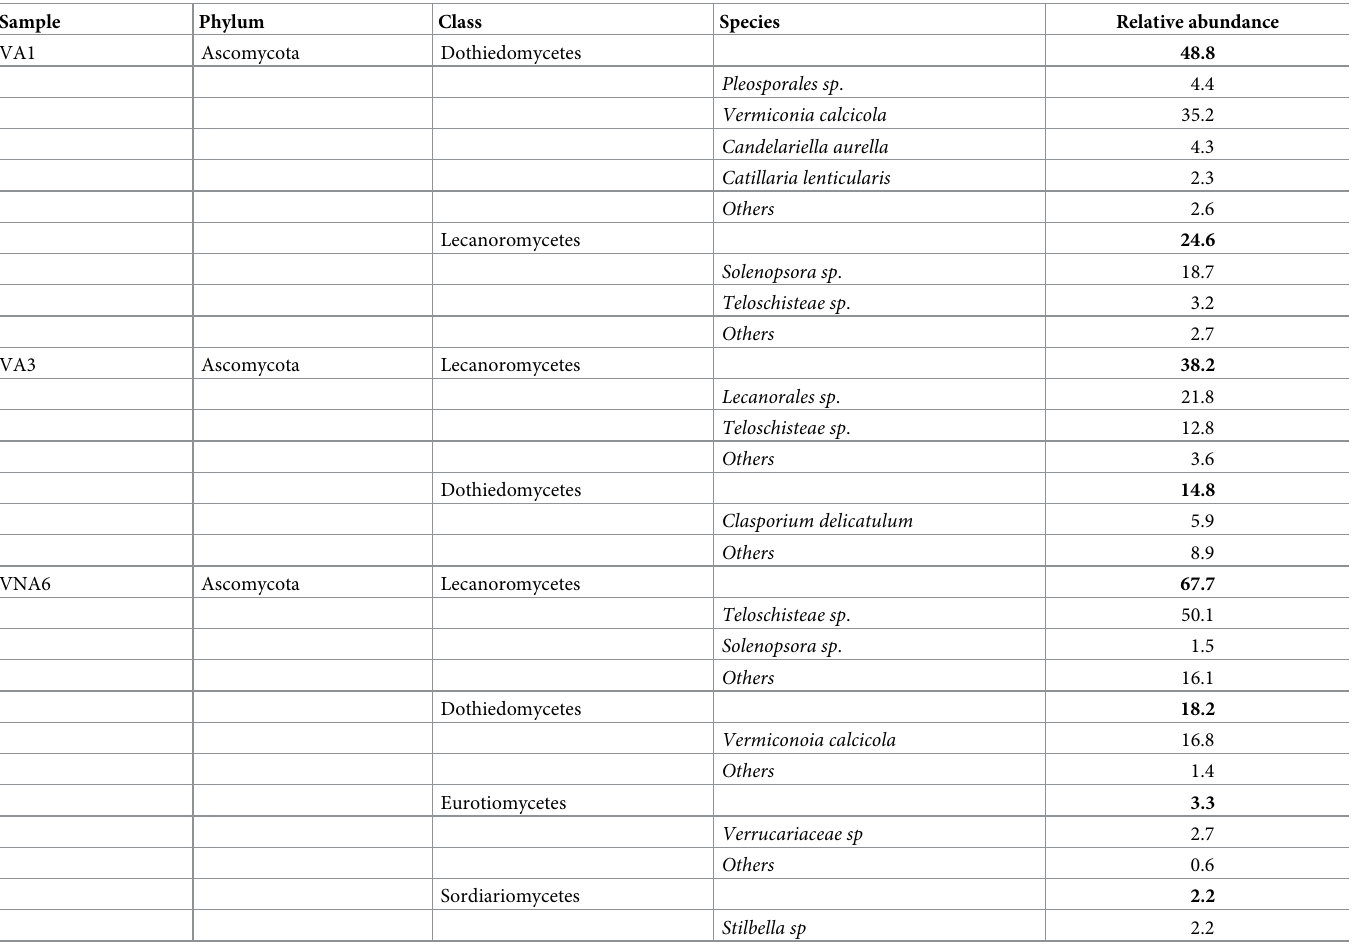
Alpha-diversity. Different indices relative to the Alpha-diversity have been calculated (Table 4). The three positions: VA1, VA3 and VNA6 showed similar Shannon’s and Simpson’s diversity index for fungi (3.05, 3.04 and 3.02, respectively, for Shannon’s index and 0.87, 0.87 and 0.88 for Simpson’s index). These values show that the microbial communities are relatively Table 2. Percent of fungi species identify for each sample. ‘Others’ corresponds to non-identified species.